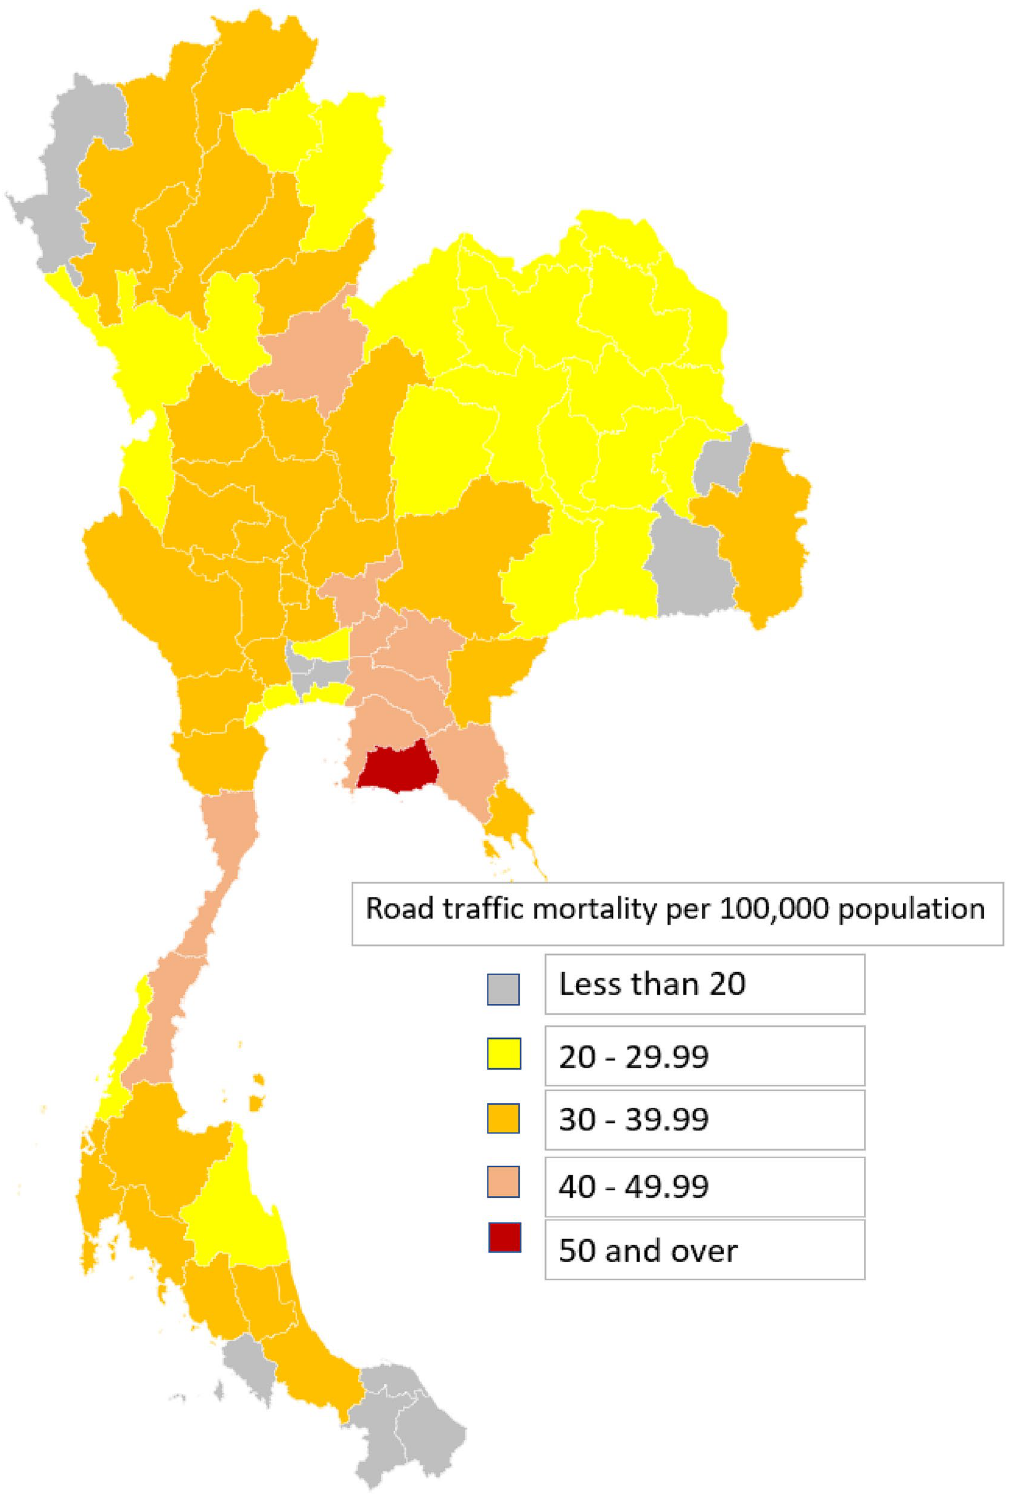
Figure 2. Heat map of Thailand illustrating the number of road traffic mortalities per 100,000 population in all 77 provinces from 2011 to